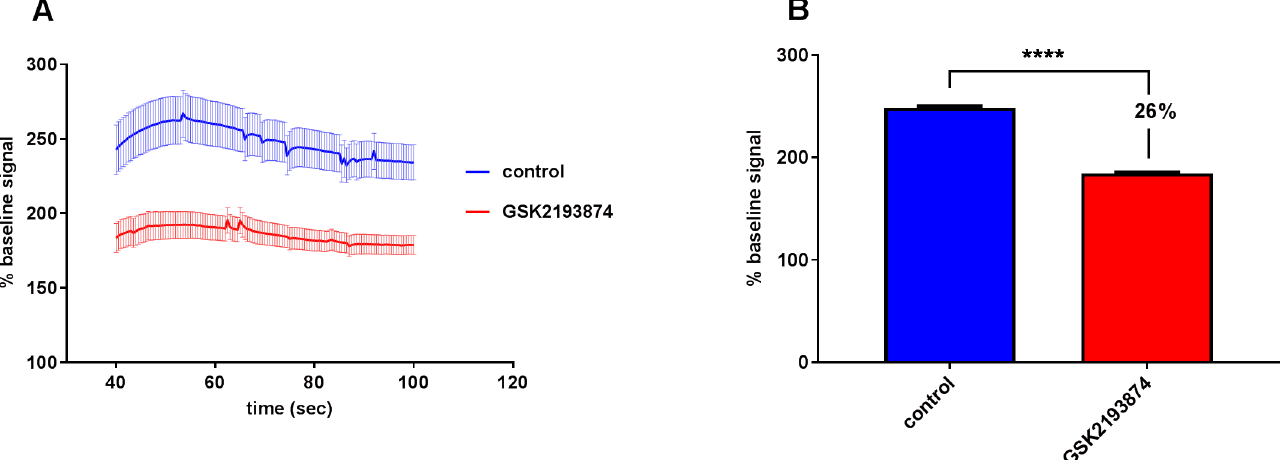
Fig 2. TRPV4 mediated calcium influx after stretch. Ca2+ response in NCI-H292 cells 10 s after a single uni-axial cell-stretch to 80% length increase and back to relaxation within 800 ms. Cells were loaded with the Ca 2+ dye fluo-4 (2 μ M) and 0.2% Pluronic F127 (Molecular Probes; Karlsruhe, Germany) and the average fluorescence values of each cell before and 10 s after the strain were determined. The strain-induced change after stimulation was expressed as the % change intensity compared to baseline signal before stretch. (A) Ca 2+ response 10 s after stretch for 60 seconds. (B) Summary of the mean % Ca 2+ response from the 60 sec after stretch, a 2.5 fold increase in the [Ca2+] i was observed that was significantly decreased by 26% with the TRPV4 antagonist (1 μ M) GSK2193874 (184.5 ± 5.07 vs 248.6 ± 10.17). For (A) and (B) data are mean ± SEM; (control n = 121; GSK2193874 n = 94, summary of 13 experiments; (cid:3)(cid:3)(cid:3)(cid:3) p < 0.0001 vs control; Unpaired two-tailed t